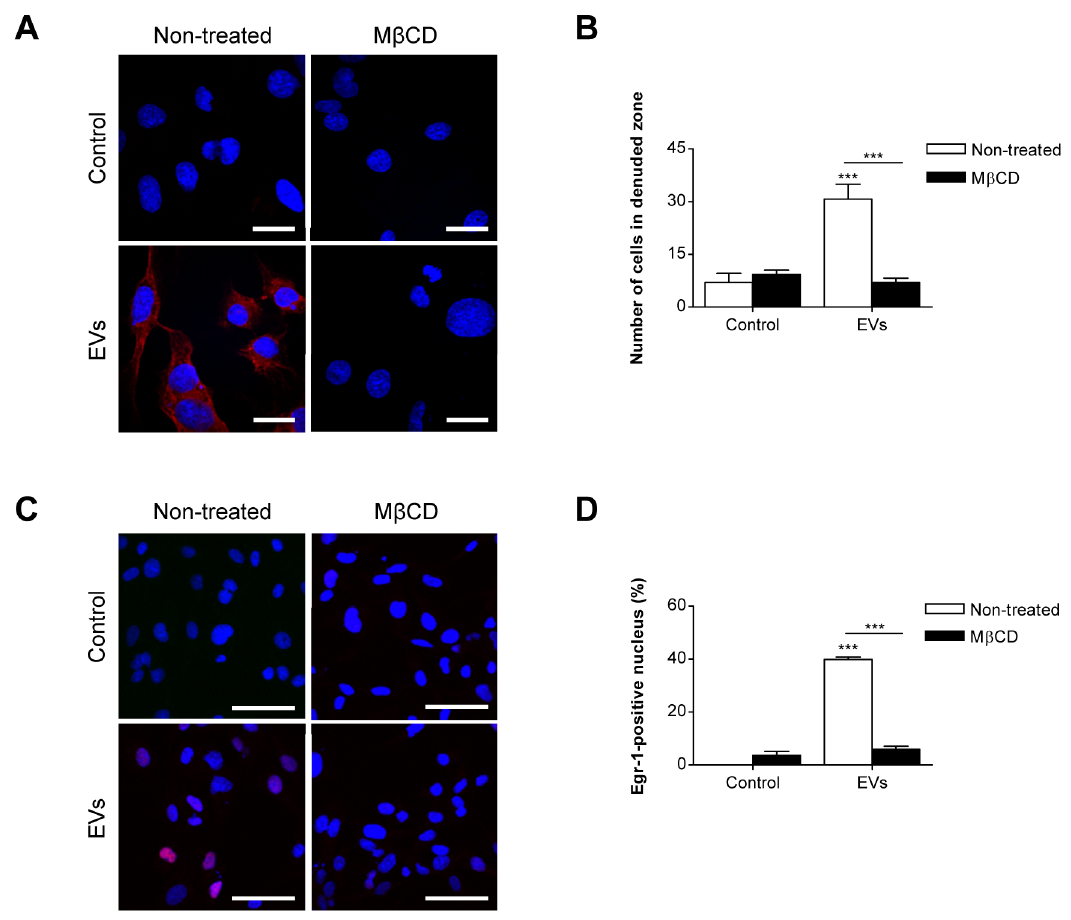
Fig. 5. Inhibition of Egr-1 activation and endothelial cell migration by M b CD. (A) HMEC-1s were treated with DiI-labeled SW480-derived EVs (1 m g/mL) for 1 h in the presence or absence of M b CD (10 mM) (n 5 3). SW480-derived EVs and nuclei were stained with DiI (red) and Hoechst (blue)